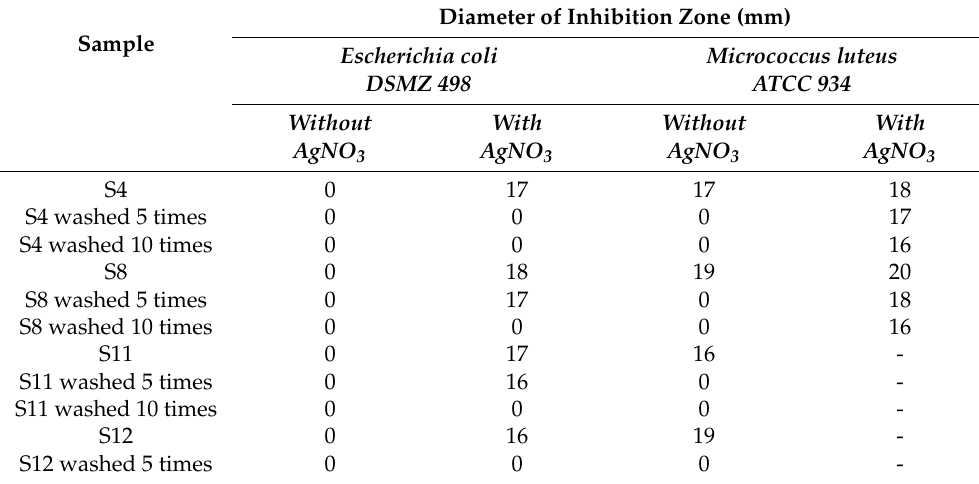
Figure 11. Images in natural light highlighting the antibacterial effects of samples S4 and S8 against Micrococcus luteus : ( a ) numbering on Petri dish lid: control sample (E), Sample S4 ( 1 ), Sample S4 washed 5 times ( 2 ), Sample S4 washed 10 times ( 3 ), Sample S8 ( 4 ), Sample S8 washed 5 times ( 5 ), Sample S8 washed 10 times ( 6 ); ( b ) after functionalization; ( c ) after functionalization and AgNO 3 treatment on all 7 samples. Table 7. Antibacterial activity against Micrococcus luteus and Escherichia coli